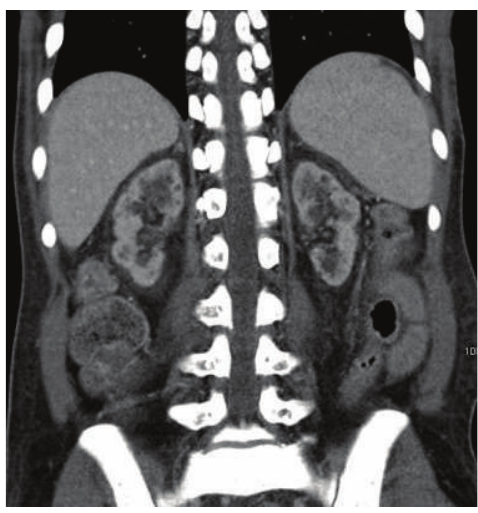
Figure 5: CT abdomen chronic cystic renal atrophy/chronic medical renal